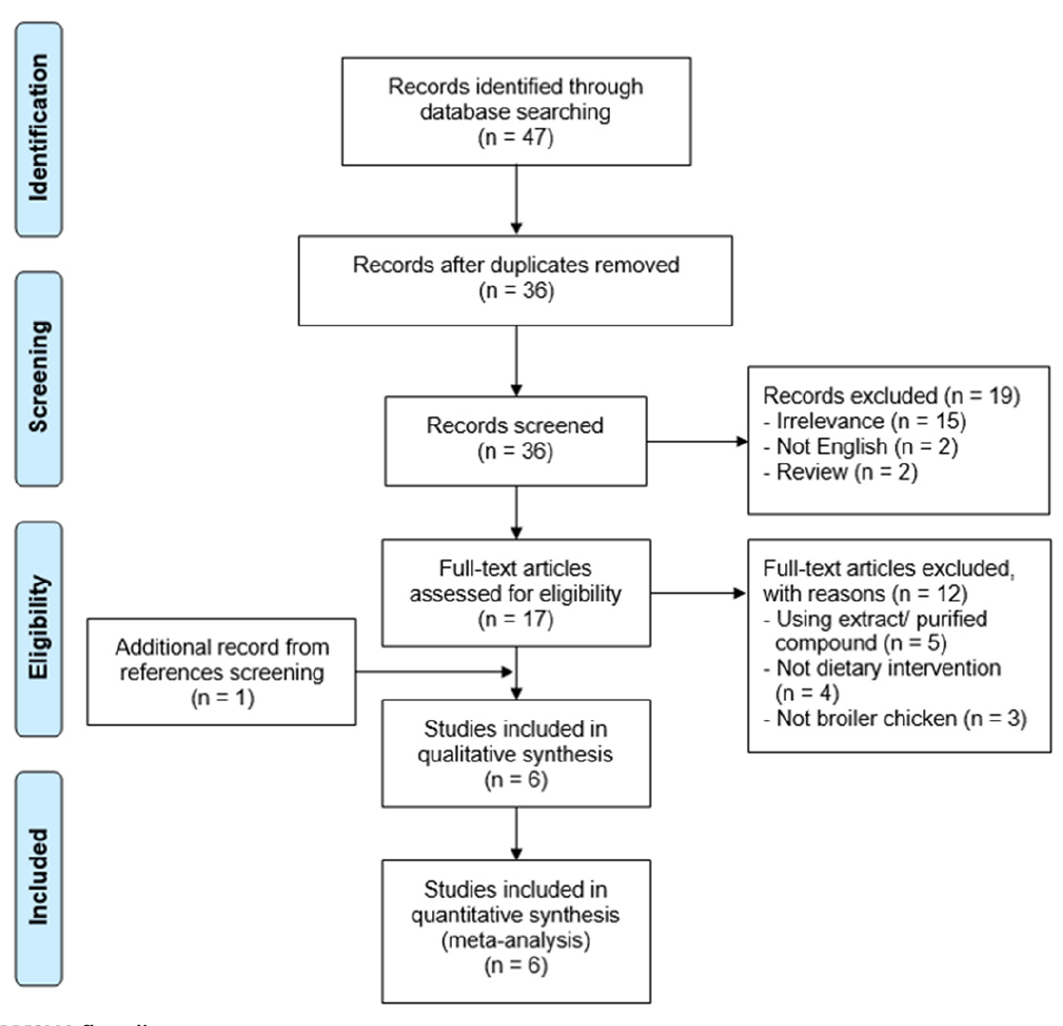
Figure 1. PRISMA flow diagram.